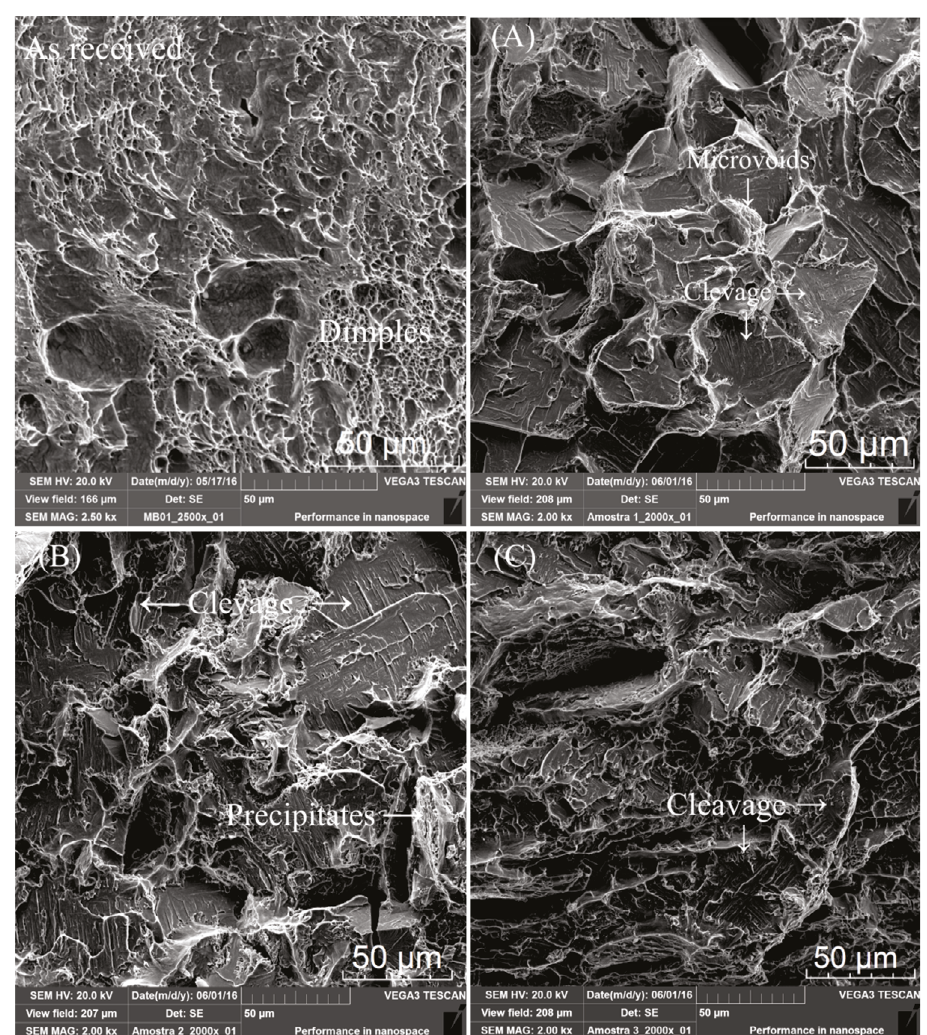
Figure 8. Impact Charpy V notch fracture surface images for ageing at 830 ºC for different times. Asreceived, A) 30 minutes, B) 90 minutes, and C) 180